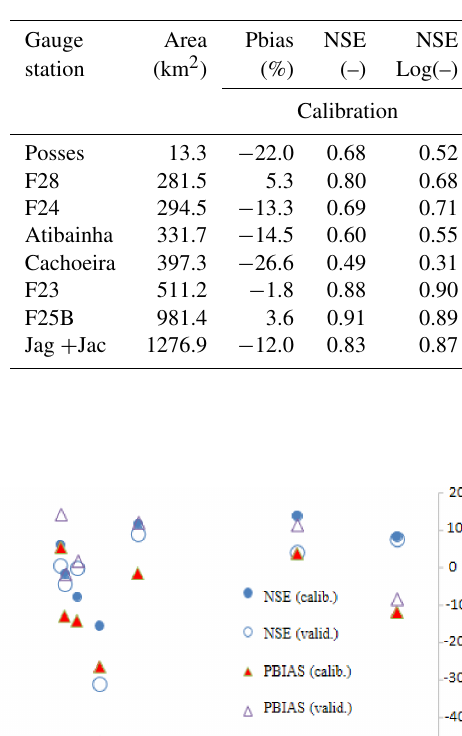
Figure 3. Land-use change during 1990 (scenario S1), 2010 (scenario S2) and 2035 (scenario S2 + EbA) in the headwaters of the Cantareira water supply system. Table 2. Characteristics of quantitative calibration and validation of SWAT in studied catchments (Moriasi et al., 2007). Area delimited by the digital terrain model (adapted from Mohor and Mendiondo, 2017).